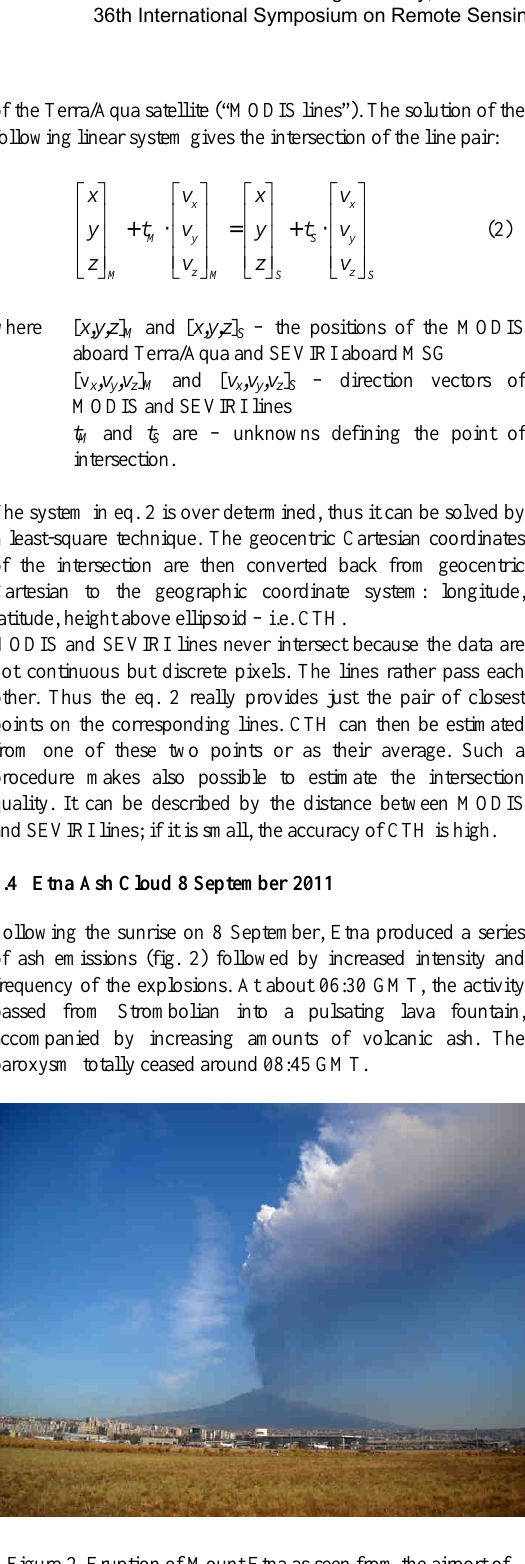
Figure 4. Cross correlation between MODIS and both SEVIRI images, estimated parallax and corresponding CTH of the ash cloud from Etna; above data from 15 min retrieval from MODIS and SEVIRI on MSG2, below data from 5 min retrieval from MODIS and SEVIRI on